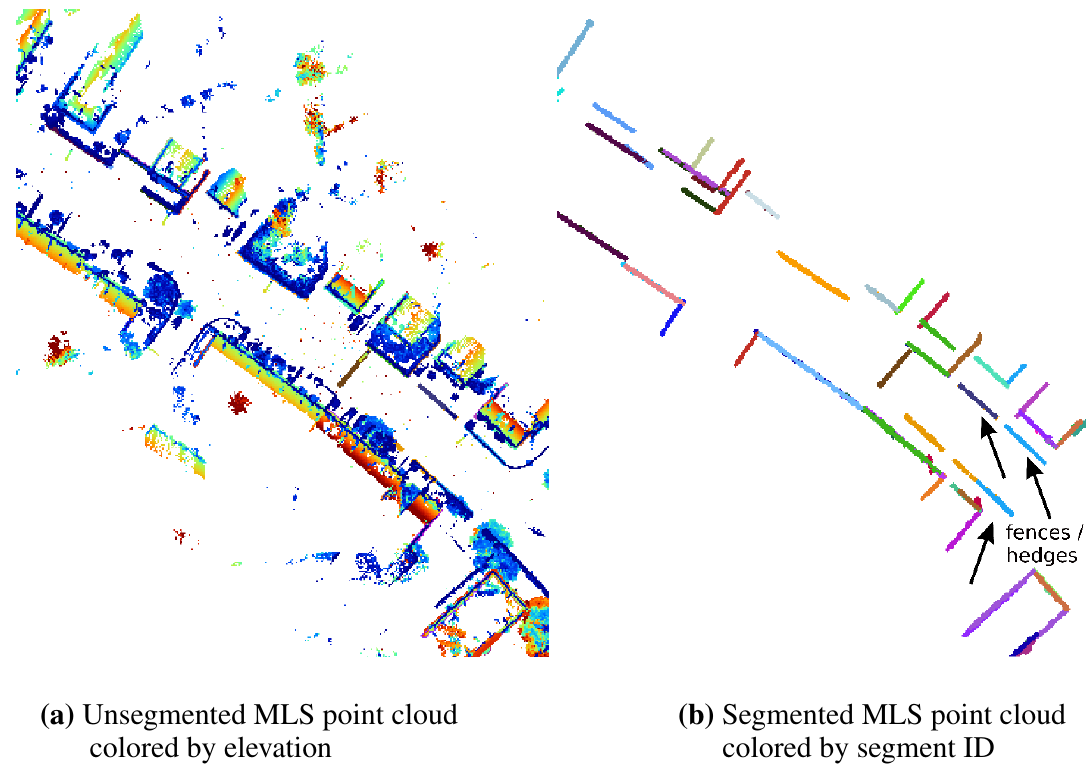
Figure 5. The original MLS point cloud (a) is compared to the segmented point cloud (b) . The original MLS point cloud is segmented into planar regions, from which vertical structures are extracted. A threshold on area size per segment is applied in order to remove small vertical structures considered to be unsuitable for the installation of solar panels.